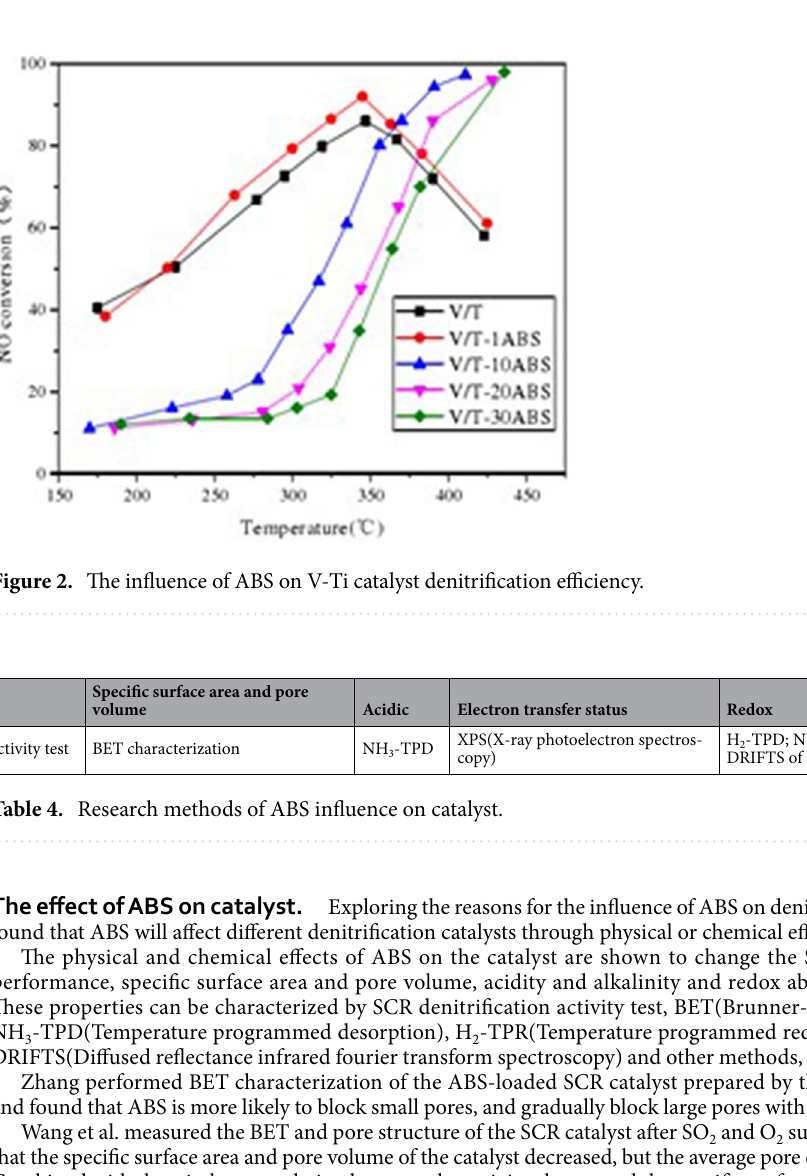
Figure 1. The influence of ABS on FeW/MCM-41denitrification efficiency.